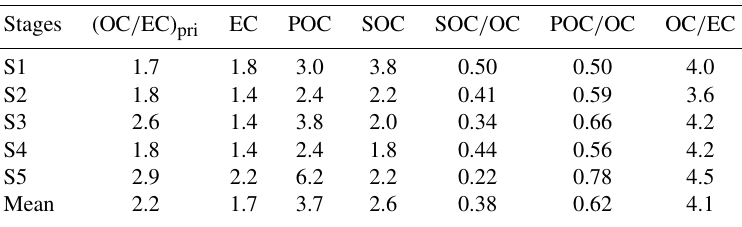
Table 1. The ratios of mean (OC / EC) pri , SOC / OC, and POC / OC and the mass concentrations (µgm − 3 ) of OC, EC, POC, and SOC during the five stages.